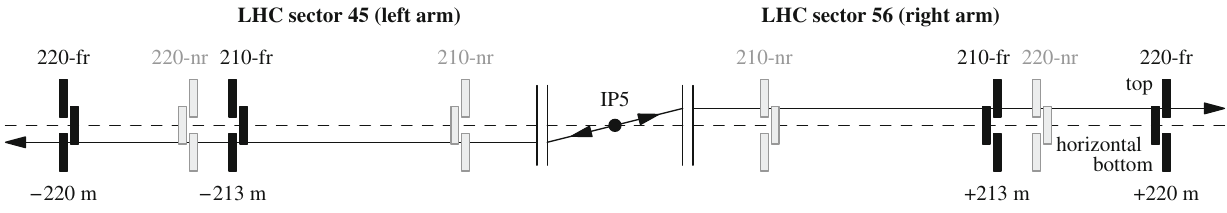
Fig. 1 Schematic view of the RP apparatus with two proton tracks from an elastic event (lines with arrows). The RPs used for the present measurement are shown as filled black boxes. The numbers at the bottom indicate the distance from the interaction point (IP5)